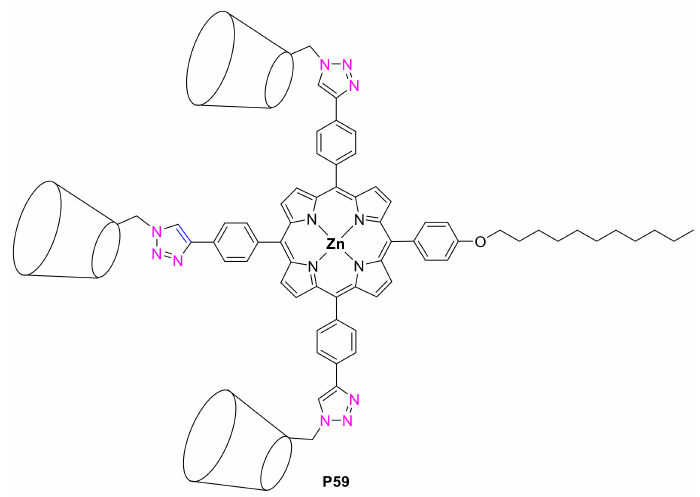
Figure 5. Structure of the amphiphilic porphyrin-cyclodextrin conjugate P59 .